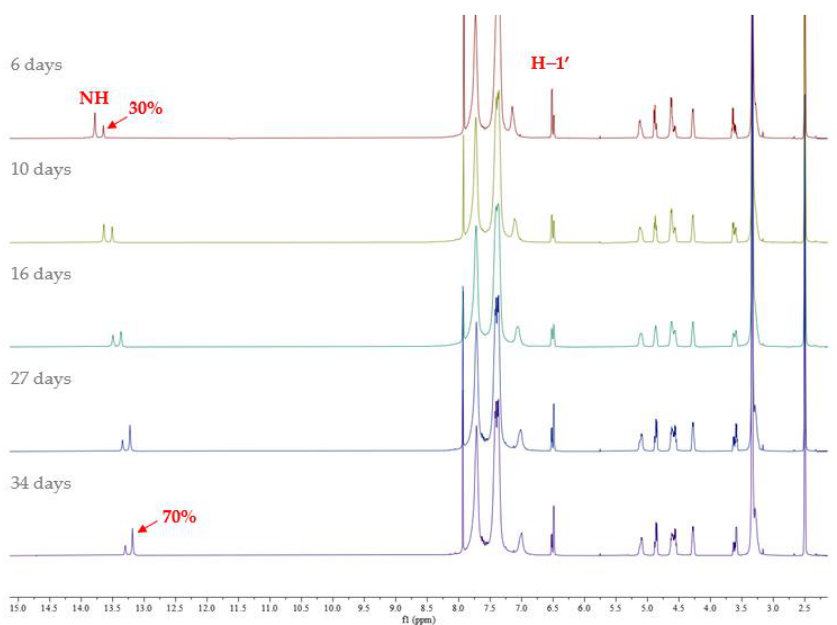
Figure 4. Evolution of the 1 H NMR spectrum of complex 5 in DMSO- d 6 at room temperature during different times. The mentioned percentages were calculated considering the signals for both NH and H-1 ′ , which were in accordance.